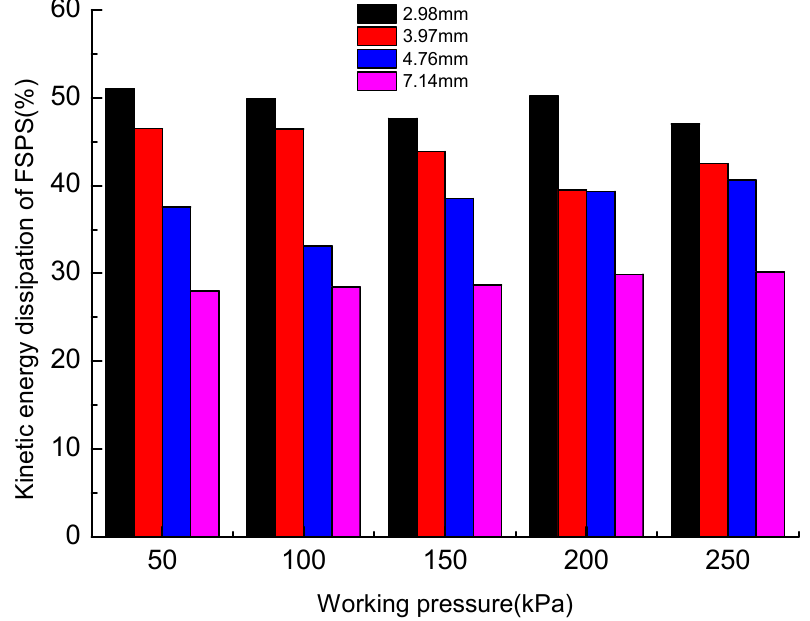
Figure 8. Kinetic energy dissipation of FSPS.